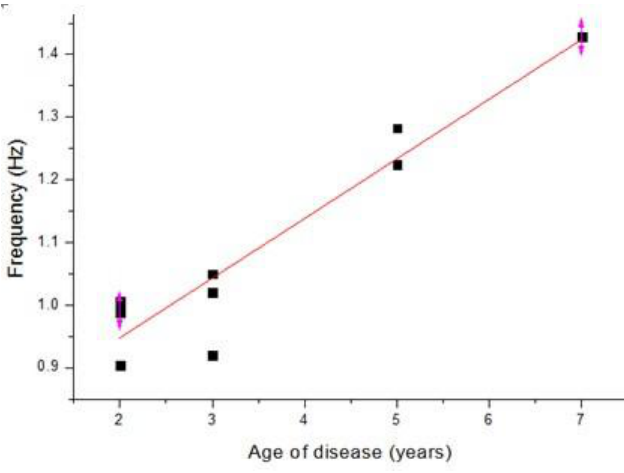
Figure 11. Postural state frequency vibration of the for sum manus in Parkinson’s disease patients dorsum